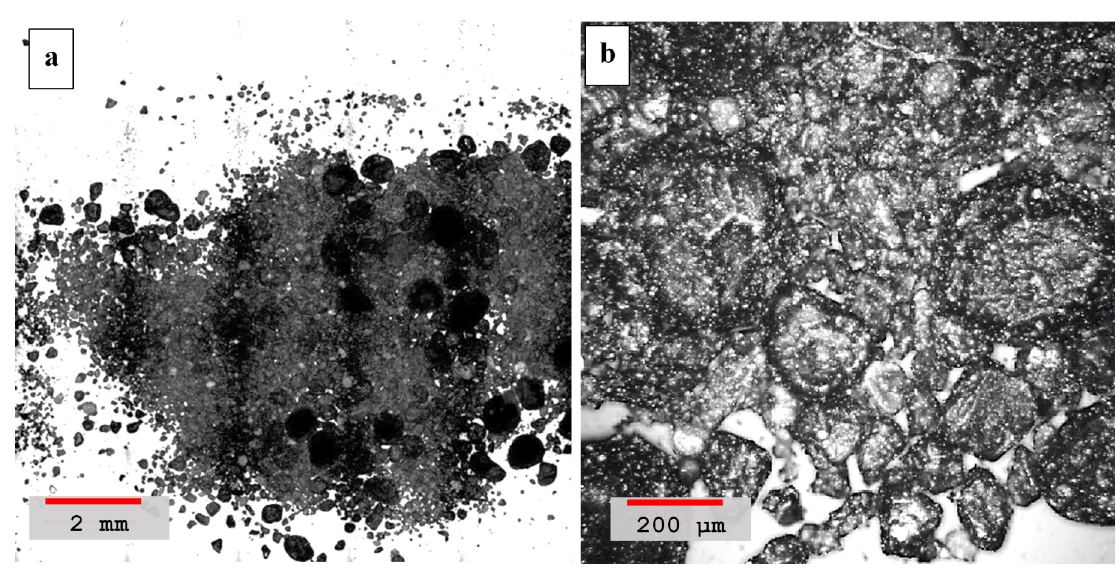
Figure 6. ( a ) Laser scanning microscopy images of hydrated volcanic ash blended mortar with sand, sample #a in Table 4, recorded at lower 5× magnification image (red color scale-bar shows ≈ 2 mm length). ( b ) Morphological image of the sample at a higher magnification of 50× with scale-bar showing ≈ 200 μ m length.